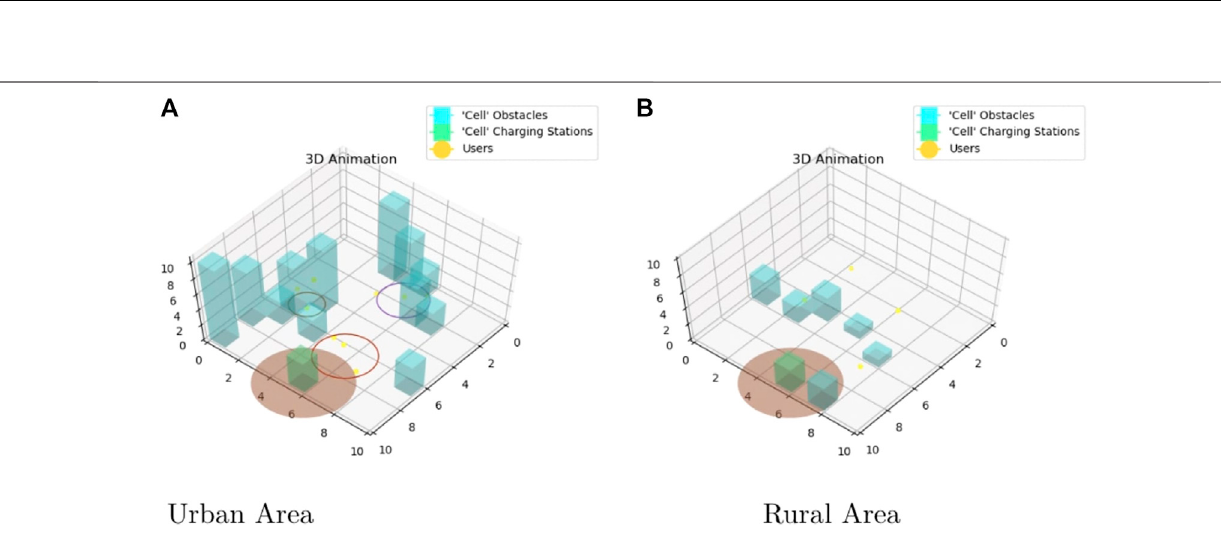
FIGURE 2 | Two different areas: Urban area (A) and rural area (B)